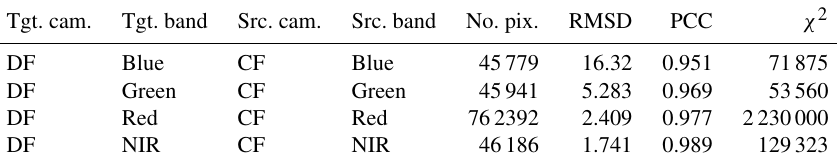
Table 2. Correlation statistics between the radiance in the four spectral bands of the target (Tgt.) camera DF and the radiance in the best- correlated source (Src.) data channels (first attempt) using all common and valid values for the G LOBAL M ODE measurements acquired in P ATH 168, O RBIT 68050 and B LOCK 110. The columns entitled “No. pix.”, “RMSD”, “PCC” and “ χ 2 ” provide the number of valid measurements common to both data channels, the root mean square difference between the data channel values, the Pearson correlation coefficient between them and the value of the statistics for the linear fit between those data channels, respectively. Tgt. cam. Tgt. band Src. cam. Src. band No. pix. RMSD PCC Blue